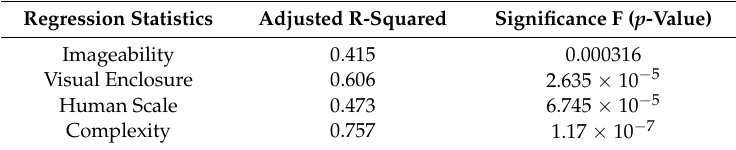
Table 3. Regression statistics of robustness of the